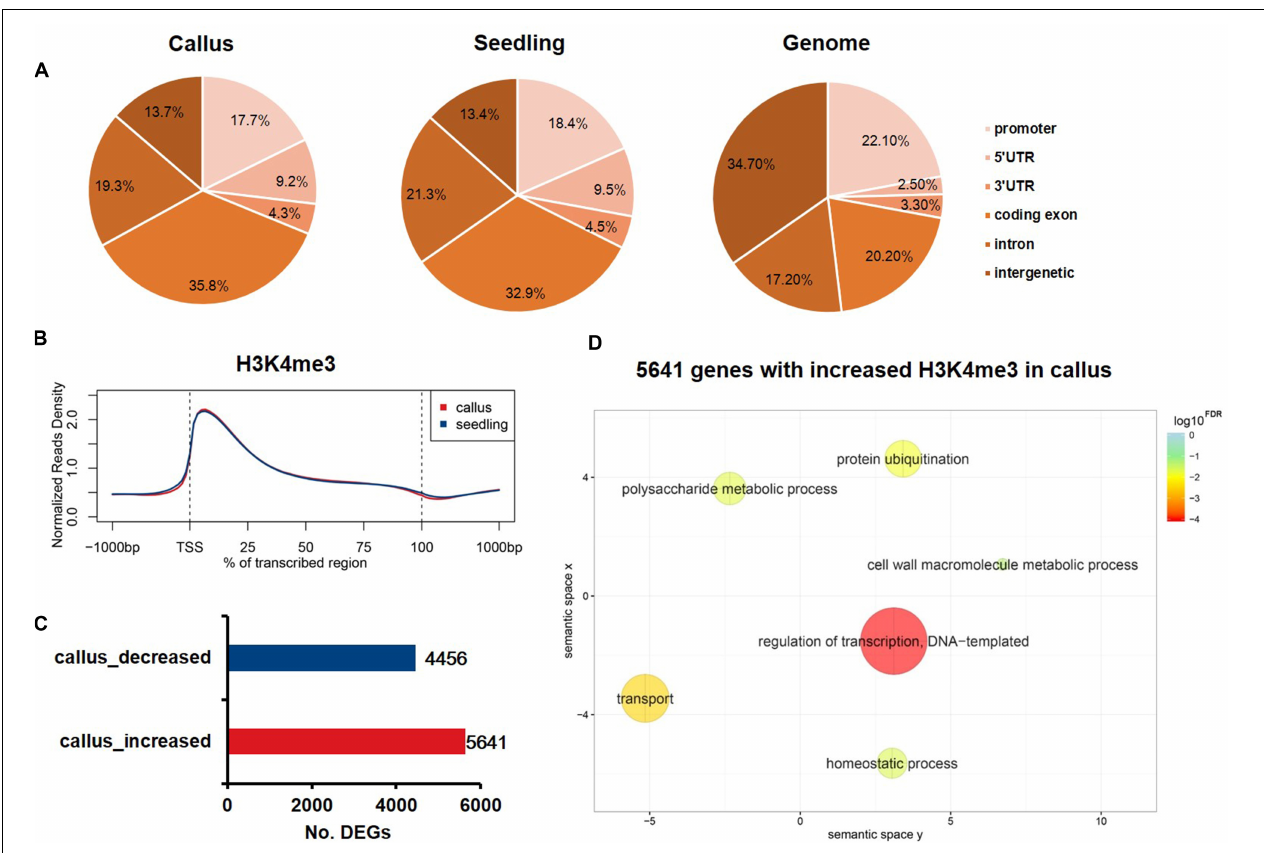
FIGURE 4 | Genome-wide profiling of H3K4me3 in rice callus and seedling. (A) Genomic distribution of H3K4me3 peaks within different regions in rice callus and seedling tissues. The rice genome was characterized into six classes that included five genic regions [promoter, 5 (cid:48) untranslated region (UTR), 3 (cid:48) UTR, coding exon, and intron] and intergenic regions. (B) The distribution of H3K4me3 along all the rice genes in the callus and seedling (from 1-kb upstream regions to 1-kb downstream regions). (C) The number of genes with differential deposition of H3K4me3 between callus and seedling. (D) GO enrichment analysis of H3K4me3-increased genes in callus by agriGO and REVIGO. The scatterplot shows the cluster representatives in a two-dimensional space derived by applying multidimensional scaling to a matrix of significant GO terms with semantic similarities. Bubble color and size indicate the log10 FDR